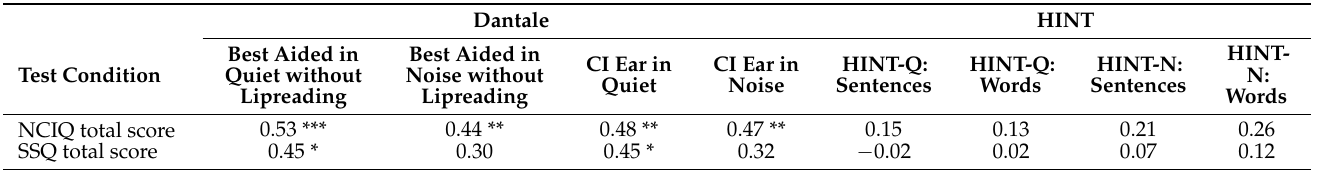
Table 6. Correlations between audiometric and patient-reported outcome measures at the second post-implantation follow-up (T2) using Spearman